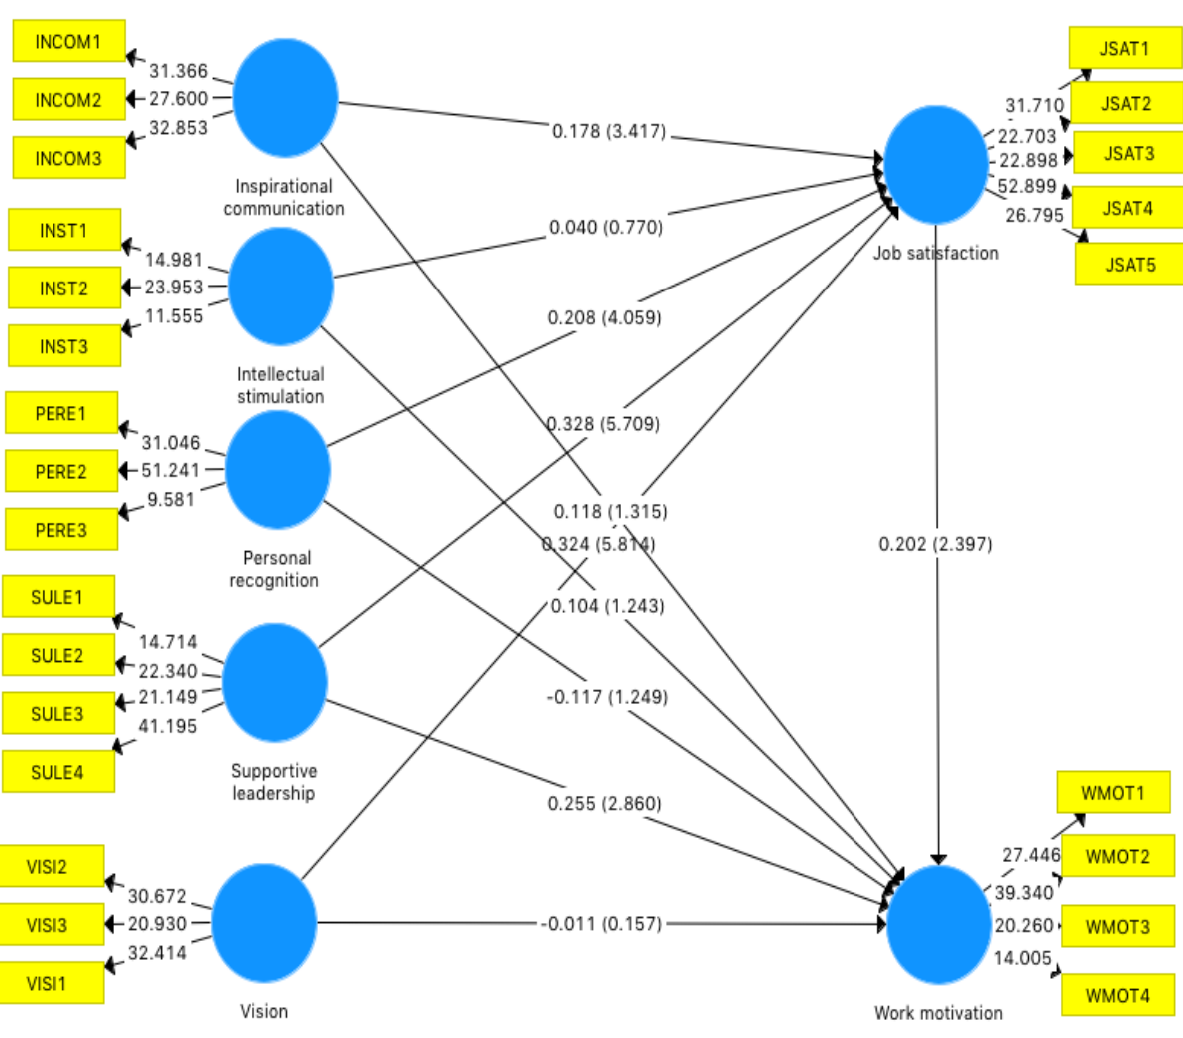
Figure 2. Results of the structural model with path coefficients.